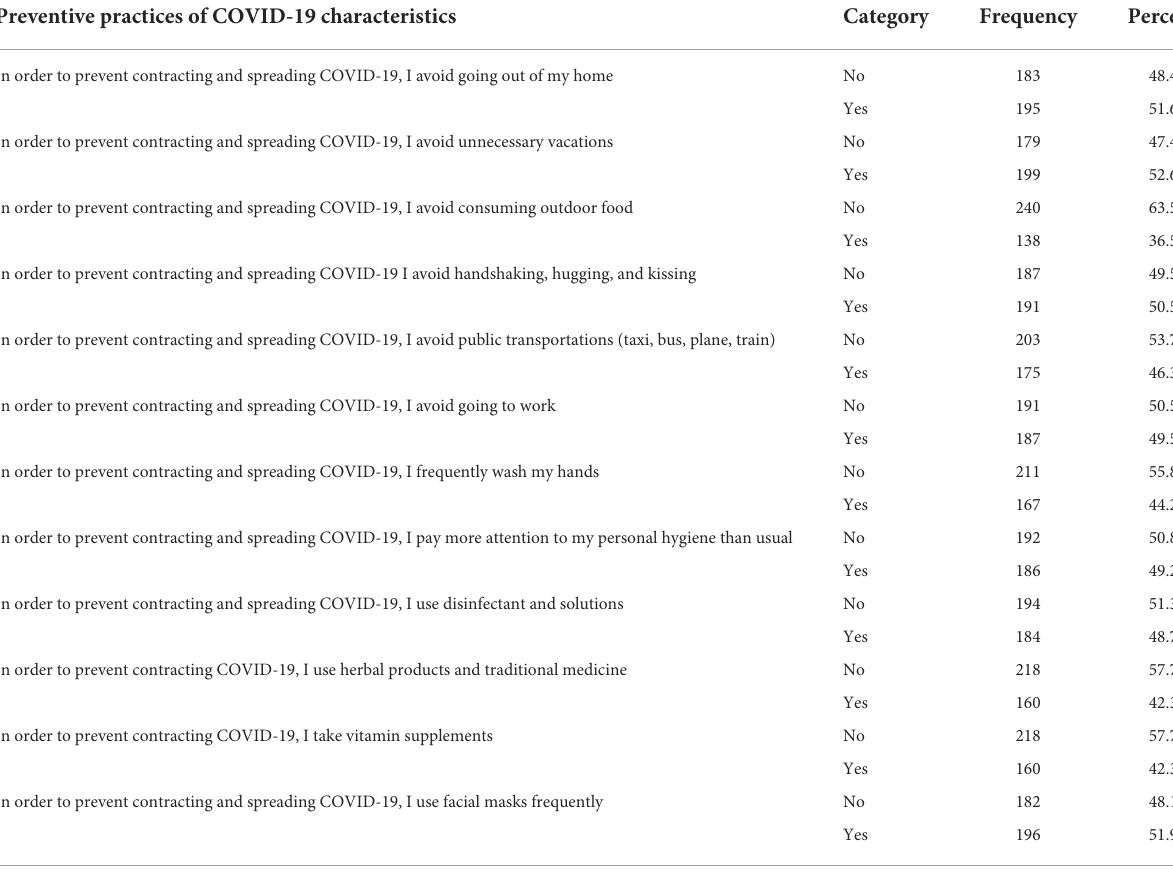
TABLE 2 Preventive practices of COVID-19 among the Ambo University community, 2022 ( n = 378). Preventive practices of COVID-19